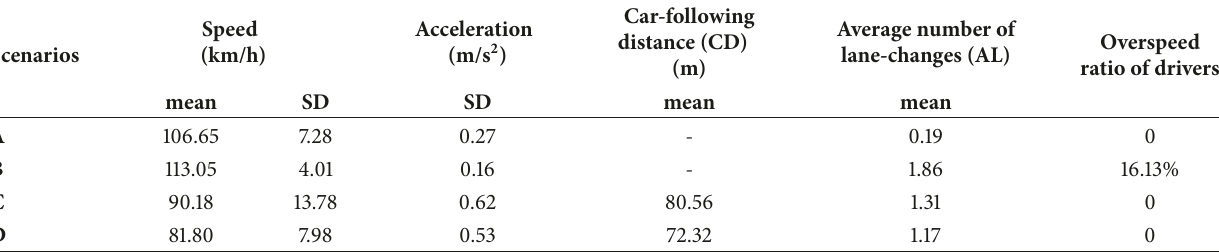
Table 2: Distribution of vehicle and drivers’ operating